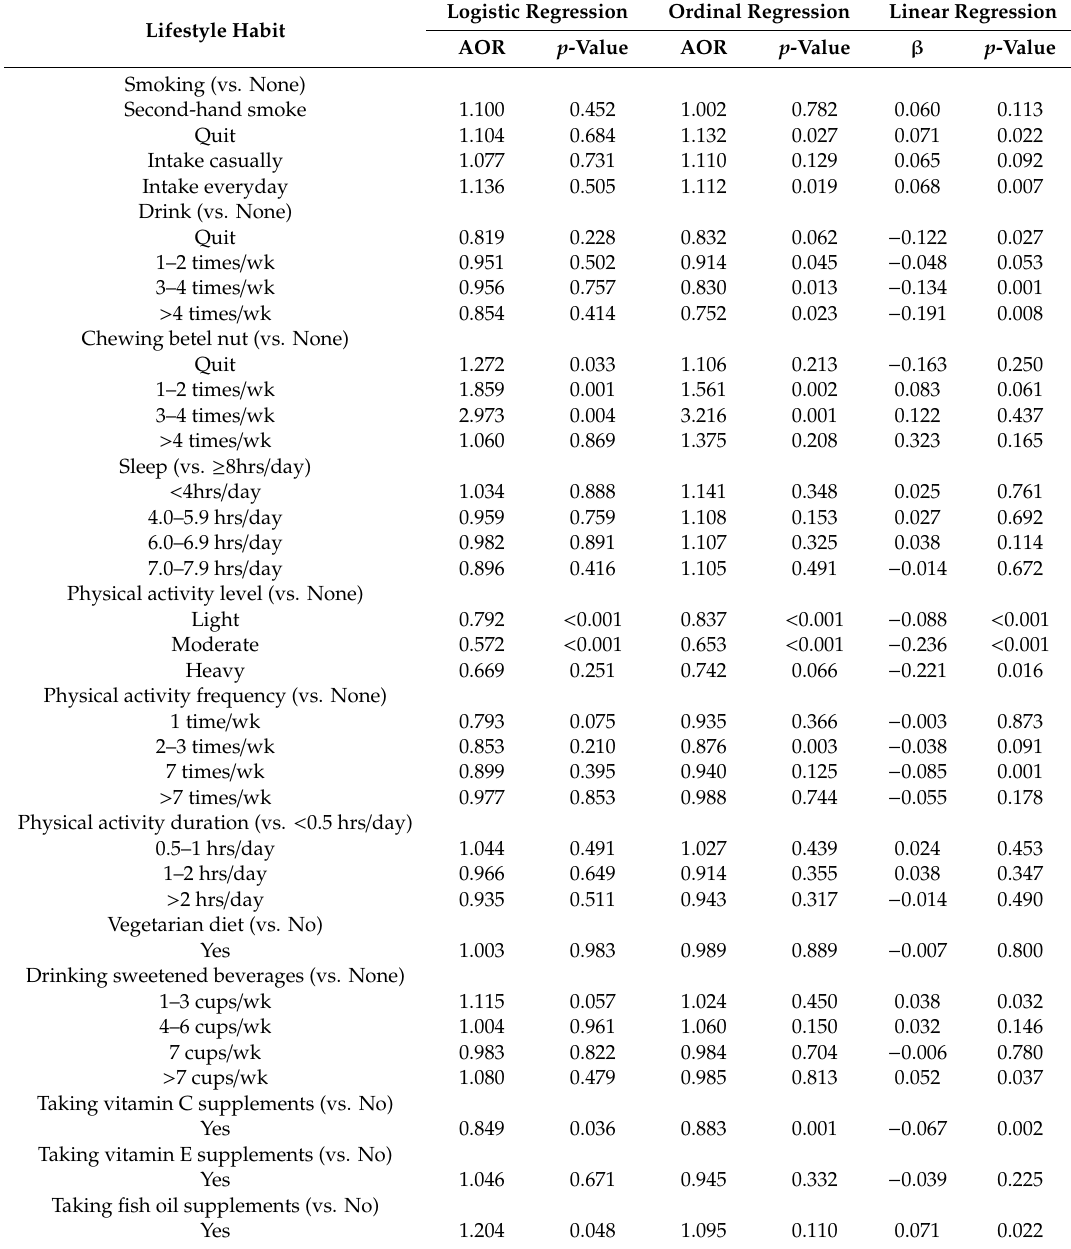
Table 5. Risk factors of lifestyle habits for metabolic syndrome in di ff erent regression models Logistic Regression Ordinal Regression Linear Lifestyle Habit